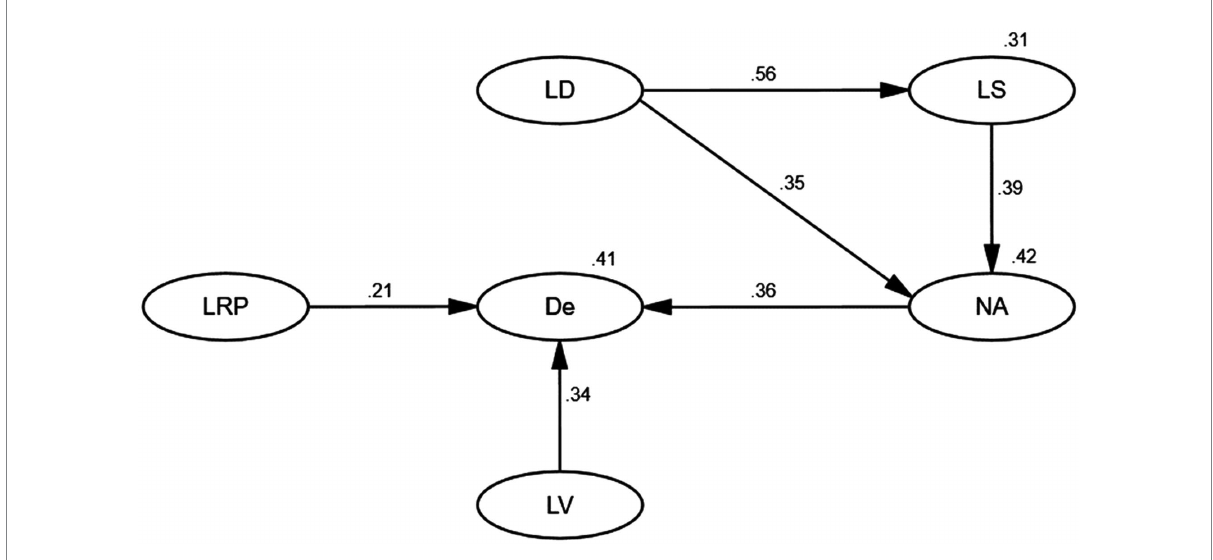
FIGURE 2 Path coefficients of the structural model (LD refers to large discrepancy between students’ actual and required positioning of English learning; LS refers to low self-efficacy; NA refers to negative affects; De refers to demotivation to learn English; LRP refers to low required positioning; LV refers to low value of learning